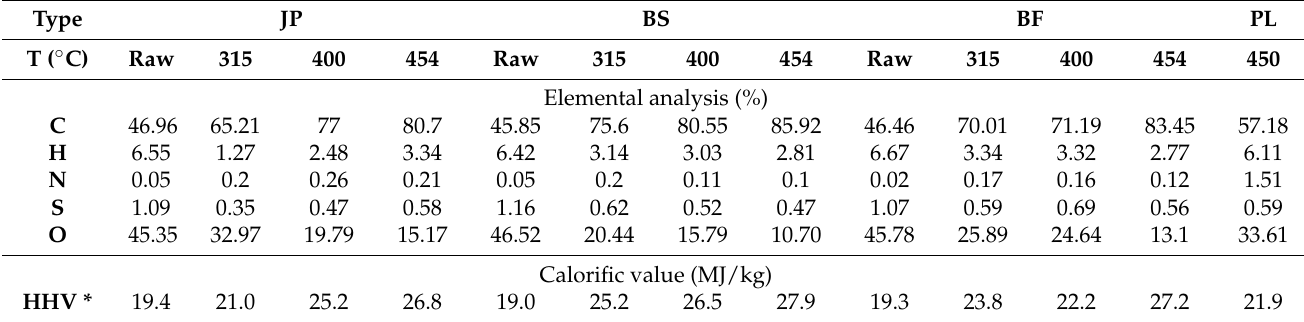
Table 1. Elemental analysis and estimated calorific value calorific value according to Equation (1) of untreated- and treated-wood residues.